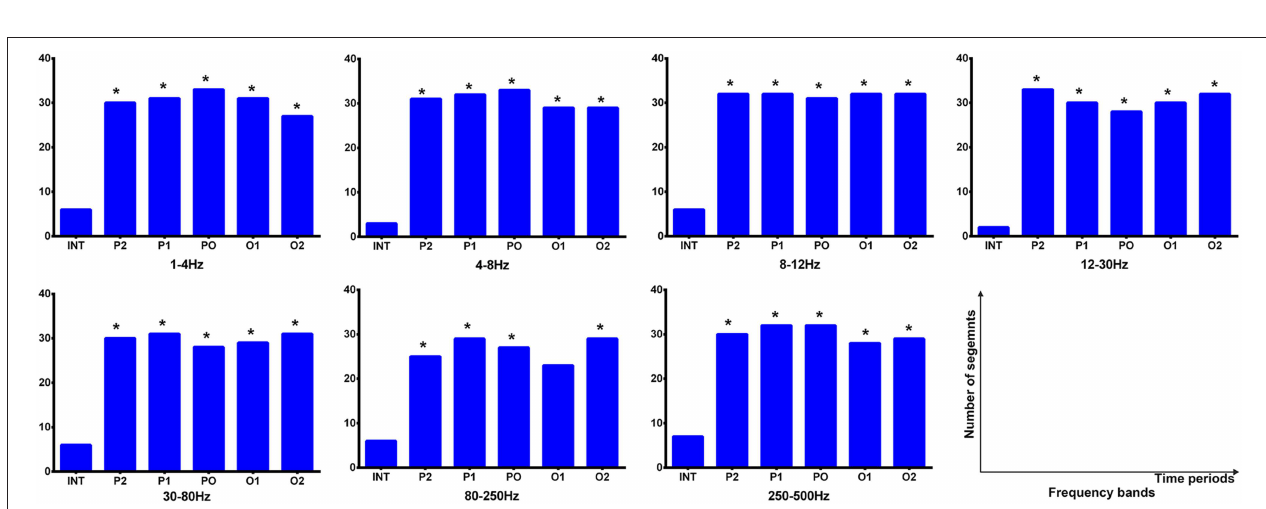
FIGURE 4 | Diagrammatic drawings and examples of typical predominant EC networks in the interictal (A) and offset transition periods (B) . In the left column (A) , the connections were mainly identified between cortical sources in the interictal periods, with both positive (red arrows) and negative (blue arrows) connections. Nevertheless, strong positive cortico-thalamic connections were observed in the right column (B) for the termination periods, and the cortex primarily drove the thalamus (shown with the red schemaball above) during seizures. Yellow dot: the driving source. Pink dot: the source being driven.